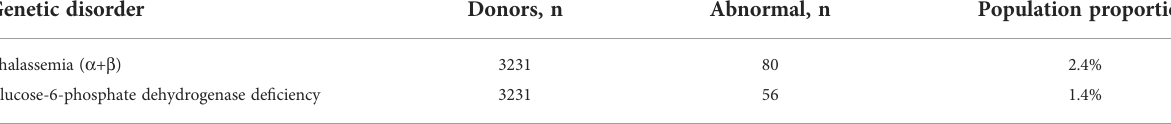
TABLE 1 Primary screening for thalassemia and G6PD with the whole blood of 3231 sperm donors. Genetic